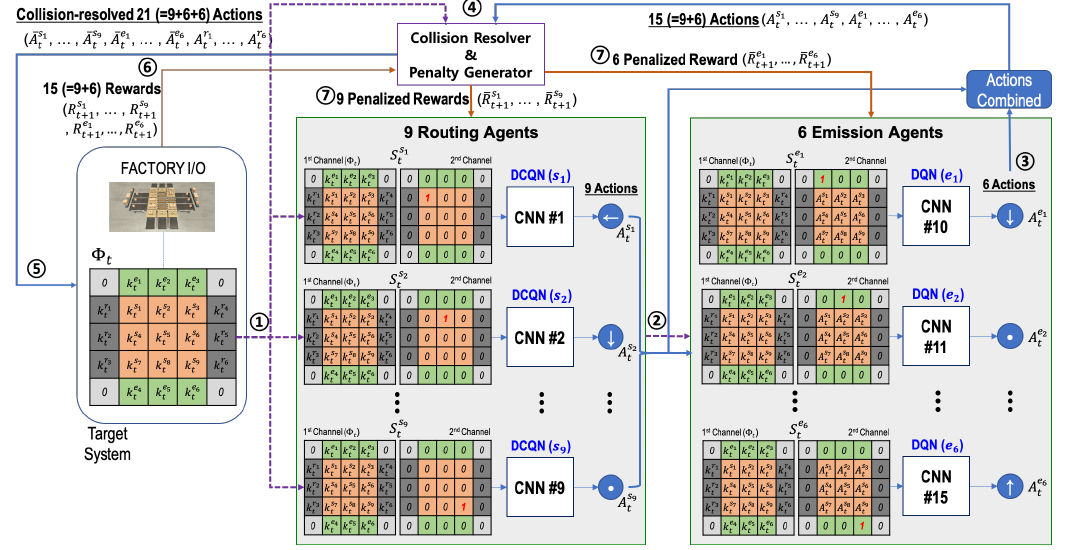
Figure 3. Behavior inference procedure by the cooperative RL multi-agent in the three-grid sortation